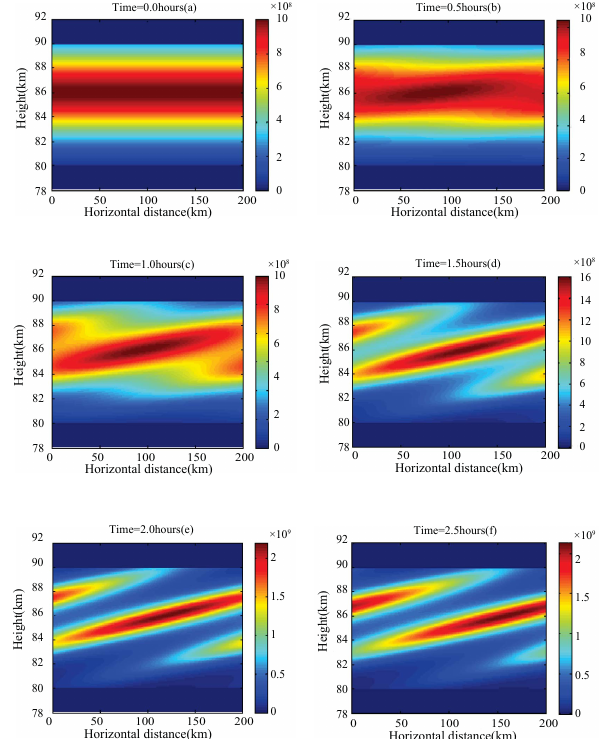
Figure 1. Ice particle layer formation and evolution plotted versus horizontal distance and height for gravity wave perturbations. The time interval is half an hour ( t = 0.0, 0.5, 1.0, 1.5, 2.0, 2.5h) for each panel.